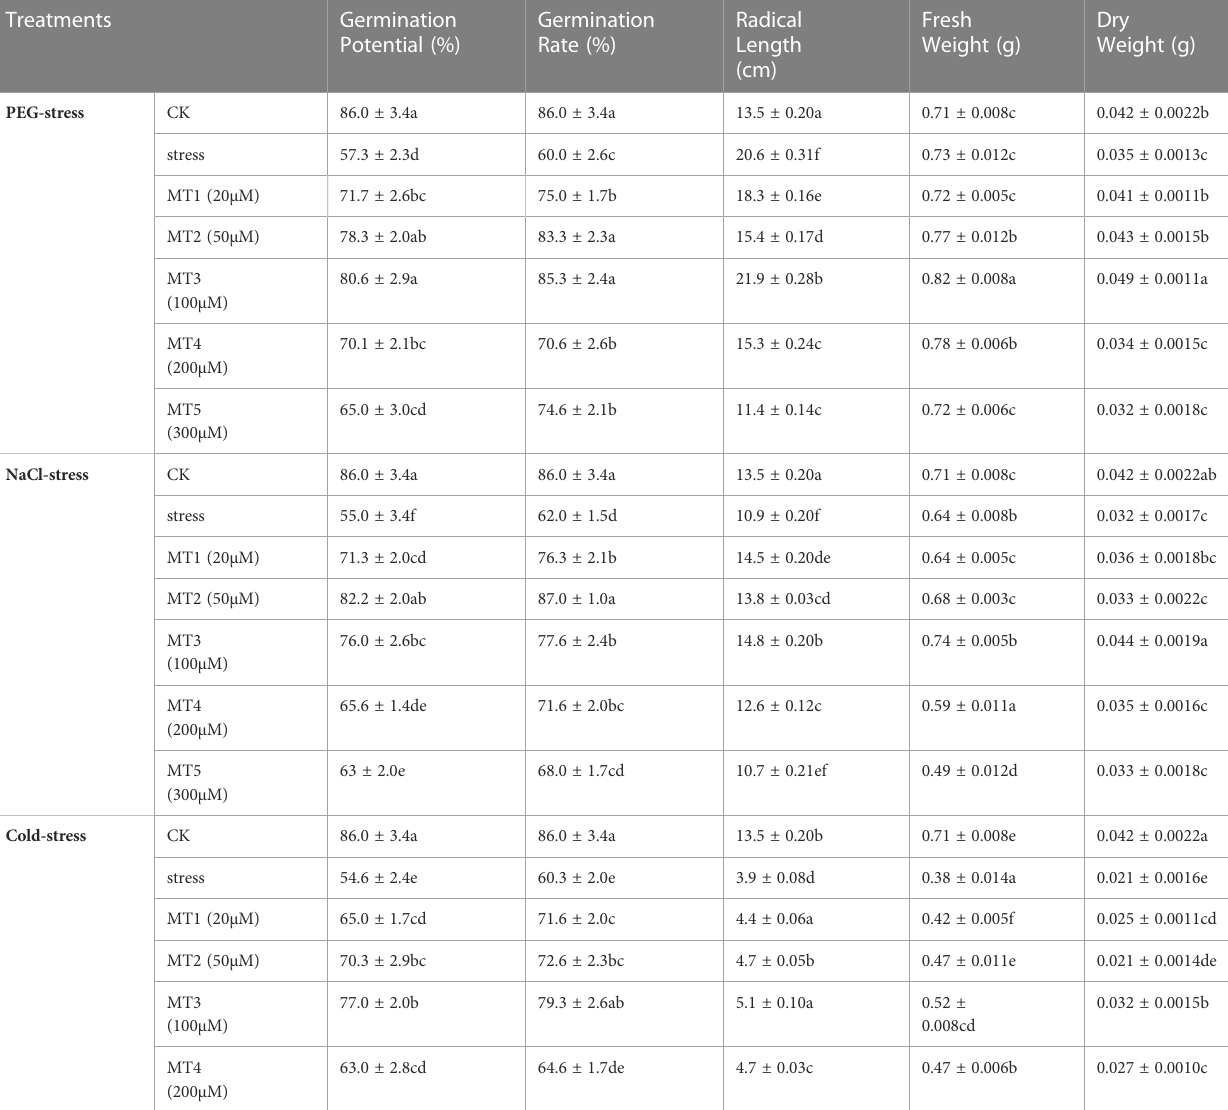
TABLE 1 Effect of different concentrations of melatonin on germination indices, radical length, and biomass of germinated soybean seeds under PEG, NaCl, Cold, and Heat stress.